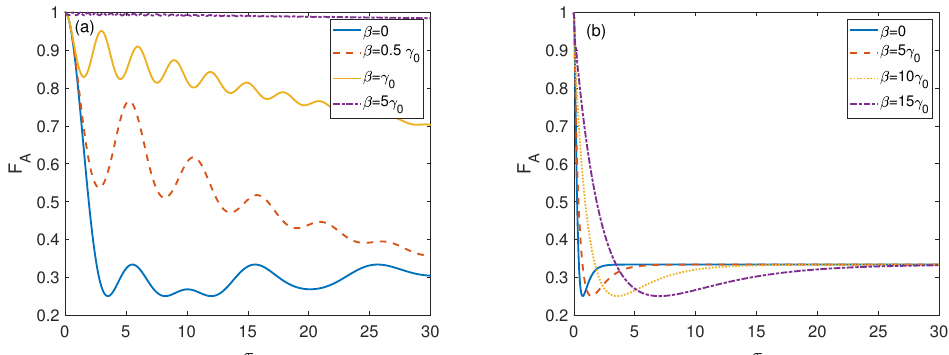
Figure 2. Average fidelity of teleportation (23) as a function of the scaled time τ = γ 0 t when √ µ = 1/ 2 for different values of Stark shift parameter β . ( a ) Non-Markovian regime with λ = 0.1 γ 0 and ( b ) Markovian regime with λ = 10 γ 0 .